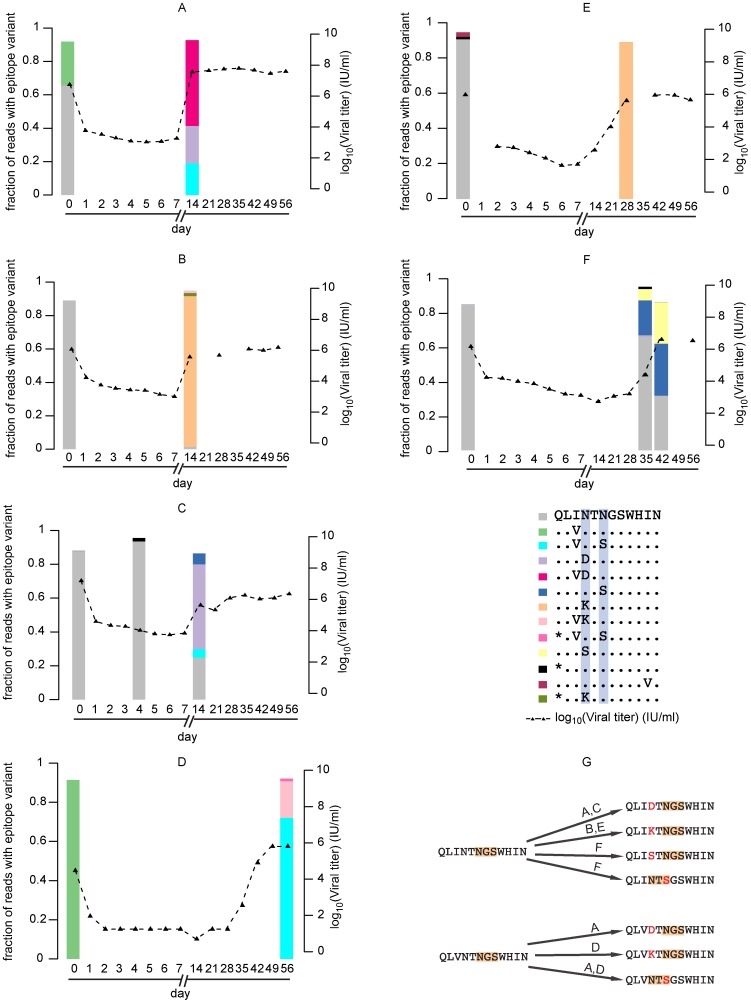
Changes in viral loads and epitope sequence distributions upon MBL-HCV1 antibody administration.
A–F: Epitope distributions for subjects A, B, C, D, E and F respectively. X axis represents time point in days, 0 denoting pre-transplant baseline sample. Note the depletion of wild-type sequence in all patients and the emergence of resistant epitope sequences (see proportions in left Y axis), in conjunction with viral rebound (right Y axis). Positions 415 and 417 are highlighted in blue in the legend. G: Summary of antibody-resistant mutations in epitope sequences, assuming maximum parsimony. Glycosylation motifs are highlighted in orange.